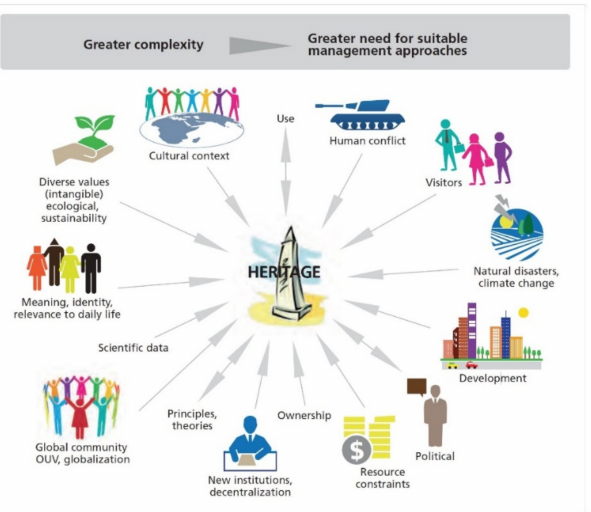
Figure 1. Examples of old and new issues in heritage management [Adapted from World Heritage Resource Manual, UNESCO, Ref.